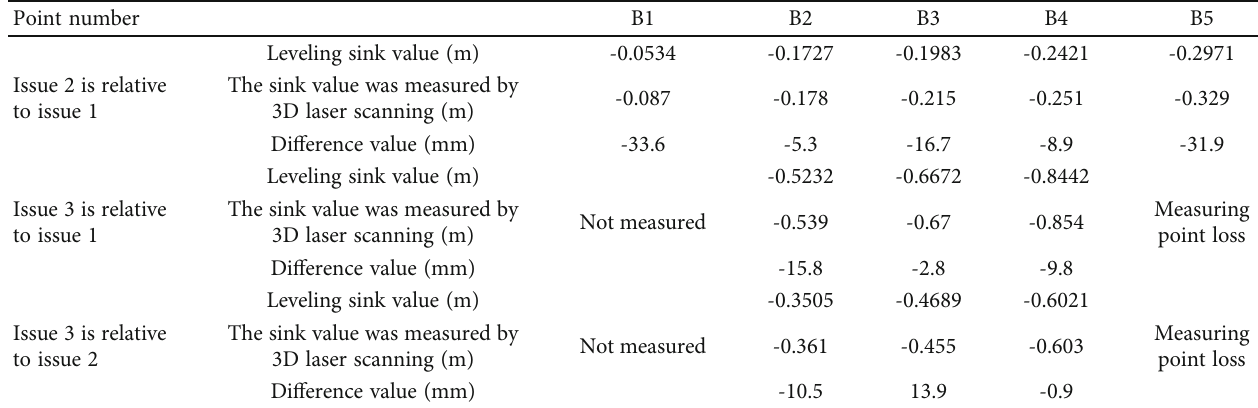
Table 2: Contrast of subsidence values in leveling and